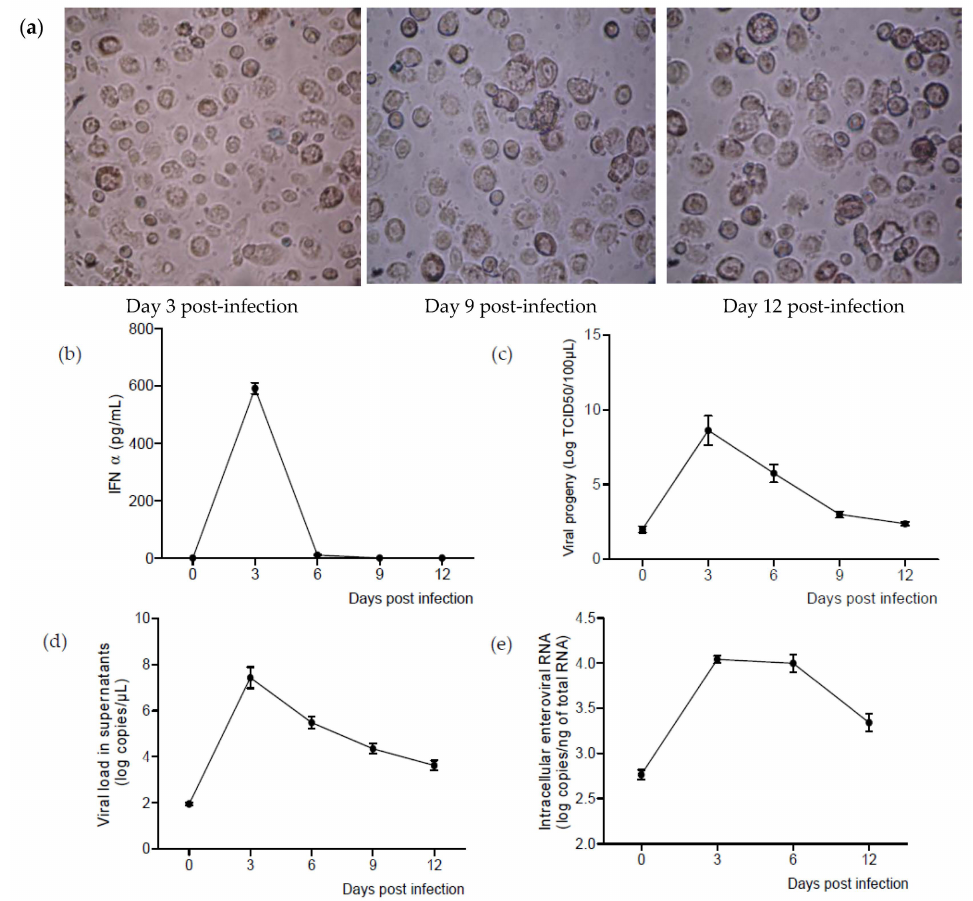
Figure 5. CVB4 can replicate and persist in M-CSF MDM. MDM treated with M-CSF for seven days were inoculated with CVB4 and were cultured for 12 days. The cell viability was assessed using the trypan blue exclusion assay ( a ). In supernatants, the levels of IFN α ( b ), infectious particles ( c ) and enteroviral RNA ( d ) were determined. In cells, enteroviral RNA was quantified by real-time RT-qPCR ( e ). These results are the mean ˘ SEM of three independent